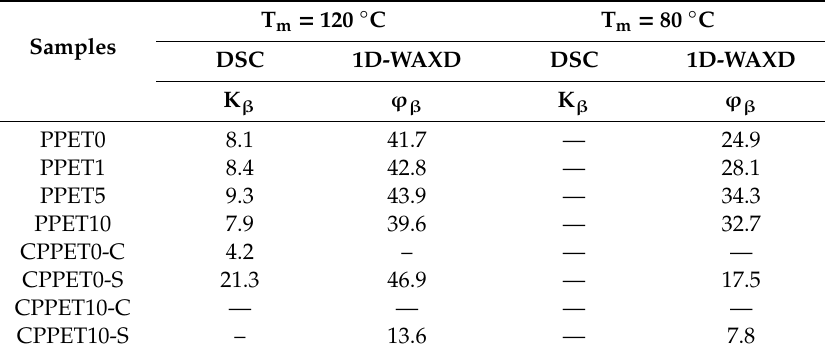
Figure 13. 1D-WAXD curves of samples: ( a ) T mold = 80 °C; ( b ) T mold = 120 °C. C represents the core layer; S represents the skin layer. Table 3. Relative content of the β -crystal.